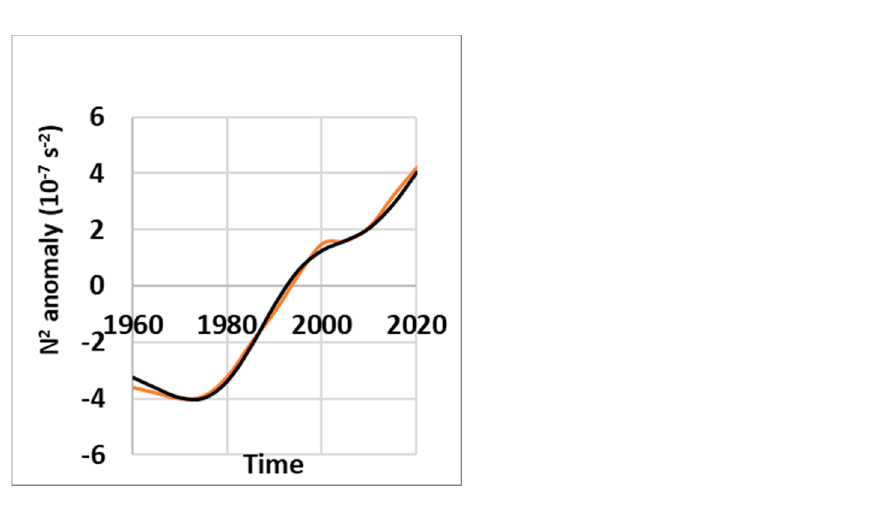
Figure 2. Time evolution of the 0–2000 m ocean stratification changes. Red curves represent the observed N 2 anomalies, black curves the weighted sum of 128-, 64-, and 32-year period sinusoids whose parameters associated to each mode are 4.9, 0.9, 0.5 s − 2 × 10 7 for the amplitude and 1972, 1960, and 1979 for the dates defining the phase.